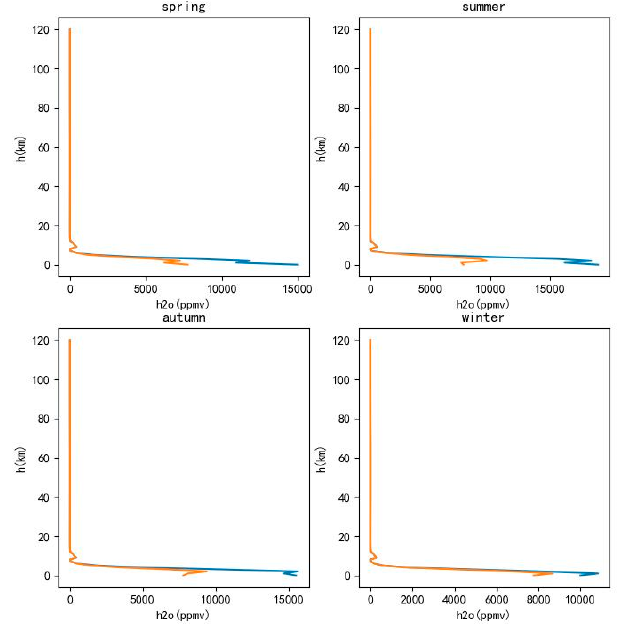
Figure 25. Water vapor profile reconstruction results (yellow curve—profile before correction, blue curve—profile after correction).